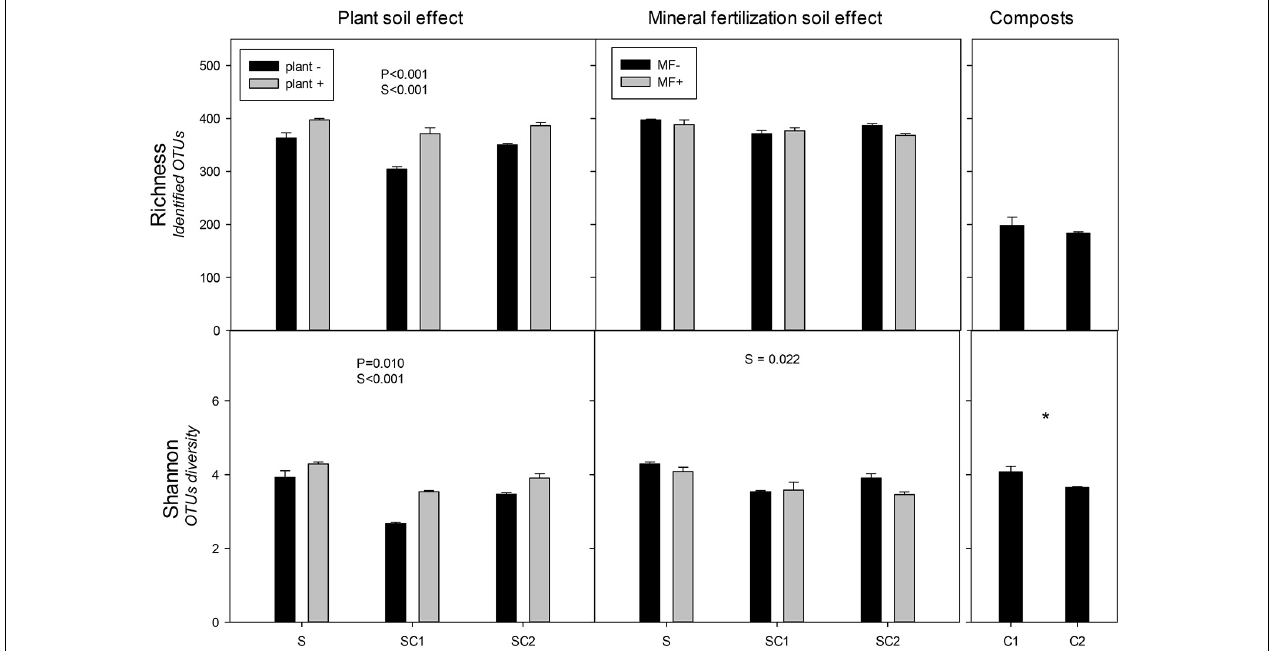
FIGURE 4 | Richness and Shannon index for the identified operational taxonomic units (OTUs) of fungi in the different soils (S, SC1, SC2) with (plant+) and without plant and in minerally fertilized (MF+) and unfertilized (MF − ) soils (S, SC1, SC2). Data on the original composts (C1 and C2) are also shown. Data represent the means and standard errors of three replicates for each sample. Significant factors of ANOVA are indicated. P, plant effect; S, soil effect; MF, mineral fertilization; S*MF, interaction of soils and mineral fertilization. Asterisk indicates significant differences between the